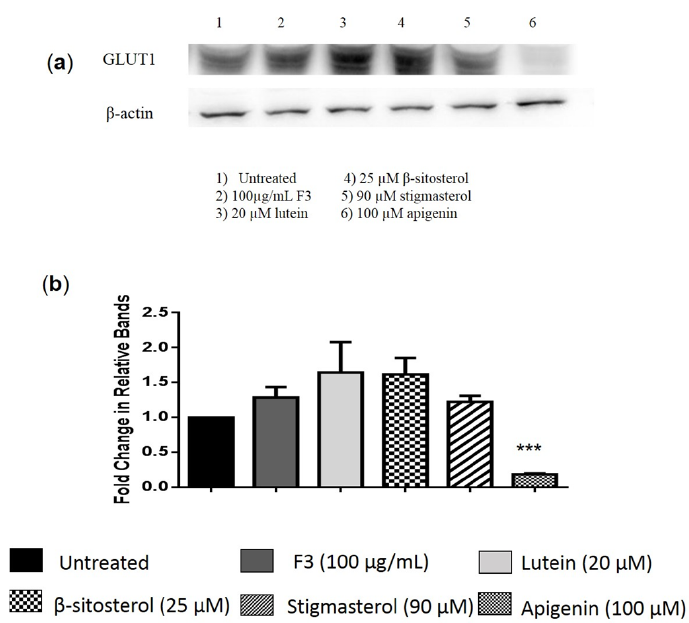
Figure 2. GLUT1 protein expression. ( a ) Representative image of Western blot analysis of MDA-MB-231 cells treated with the indicated concentrations of (2) F3, (3) lutein, (4) β -sitosterol, (5) stigmasterol, and (6) apigenin (positive control), while (1) untreated as a negative control for 24 h. ( b ) Results are presented as an average fold change in the level of each protein normalized to β -actin ± SD ( n = 3). *** p <